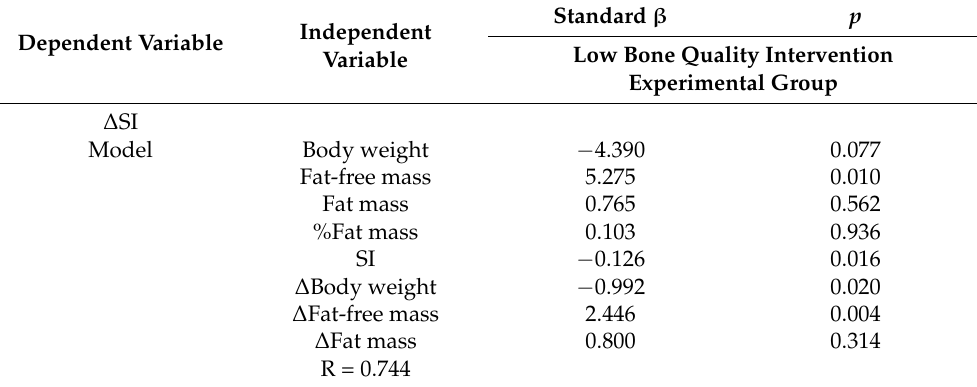
Figure 2. Mean difference (95% CI) after the 8 month exercise intervention in calcaneal bone quality and body composition in experimental group and observation control group. * p value determined by student’s t-test for differences in the basic characteristics of baseline and outcome, * p < 0.05; SI indicates stiffness index, SI = 0.67 × BUA + 0.28 × SOS − 420; BW indicates body weight; FFM indicates fat-free mass; FM indicates fat mass; BMI indicates body mass index. Table 4. Multivariate regression analysis of changes in calcaneal bone quality in the low bone quality intervention experimental